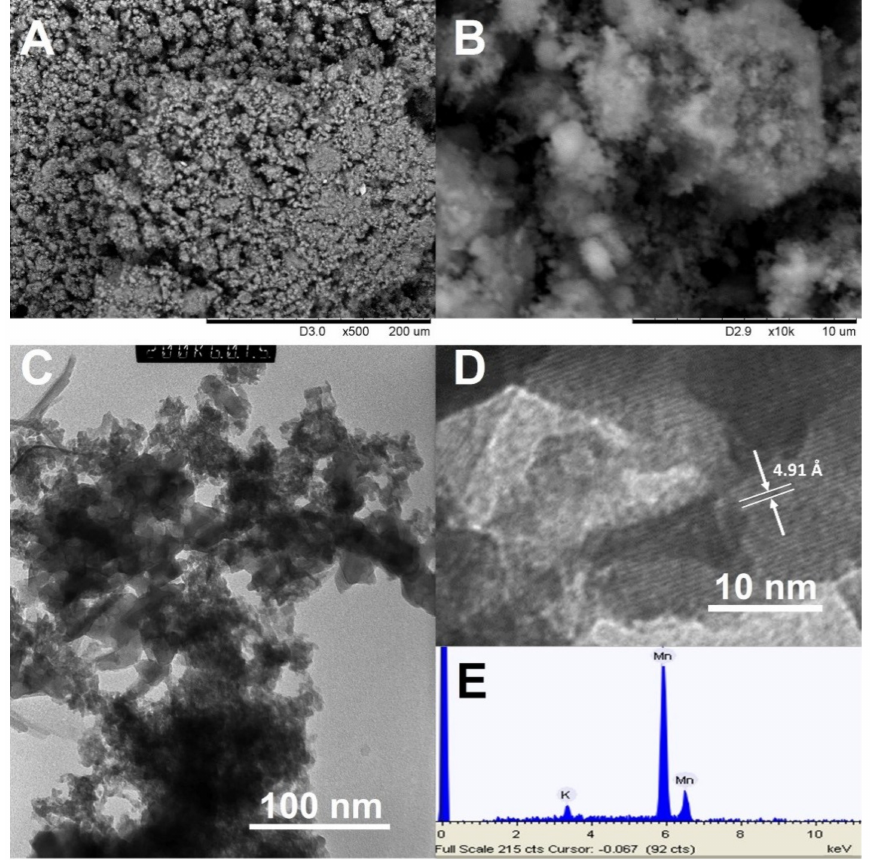
Figure 2. SEM ( A , B ) and TEM ( C , D ) images and EDS analysis of the α -MnO 2 obtained ( E